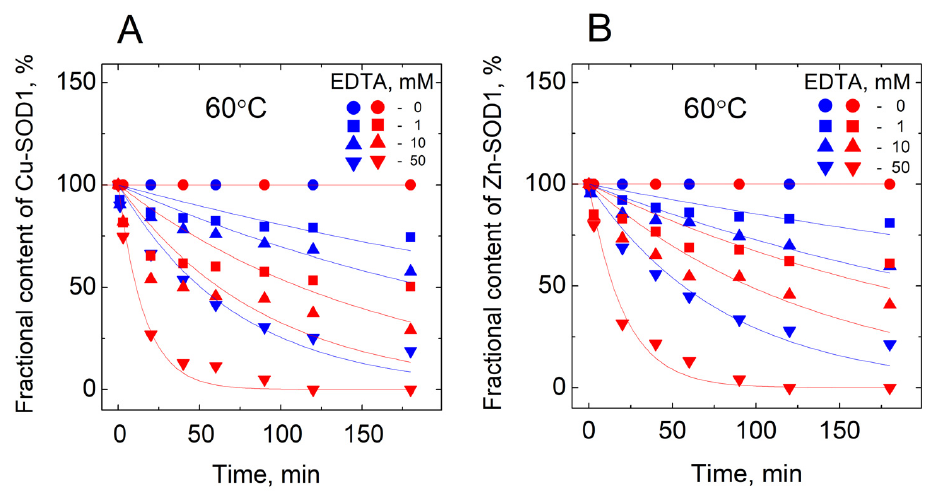
Figure 3. Demetallation of wt Cu,Zn-SOD1 and its G93A mutant in the presence of EDTA monitored by LC-ICP-MS. ( A ) fraction of Cu bound to-SOD1; ( B ) fraction of Zn bound to SOD1. Conditions: 10 µM wt Cu,Zn-SOD1 (blue symbols) and 10 µM of its G93A mutant (red symbols) in 50 mM HEPES/50 mM NaCl, pH 7.3 at 60° C.